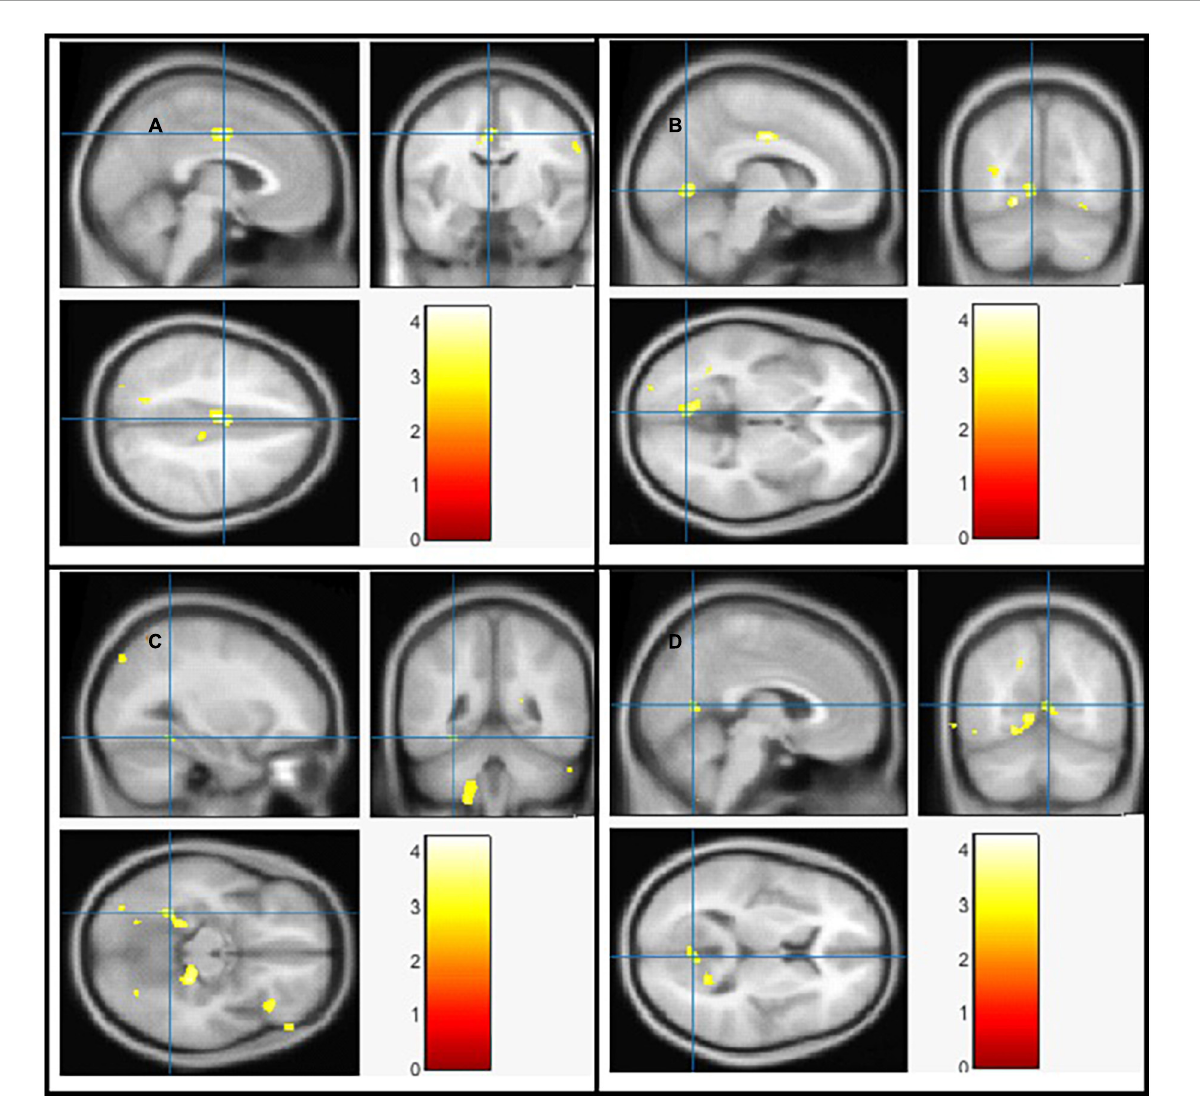
FIGURE2 The significant gray matter (GM) alterations by VBM analyses with the covariate of no interest (TIV) in the left middle cingulate (A) , left lingual gyrus (B) , left fusiform gyrus (C) , and right calcarine (D) , respectively when PD < controls with p < 0.05 and extent threshold K =